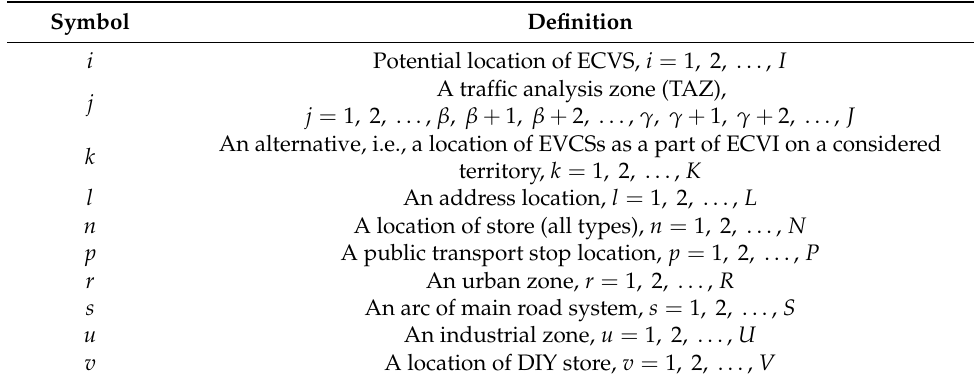
Table 1. This list of indexes in alphabetical